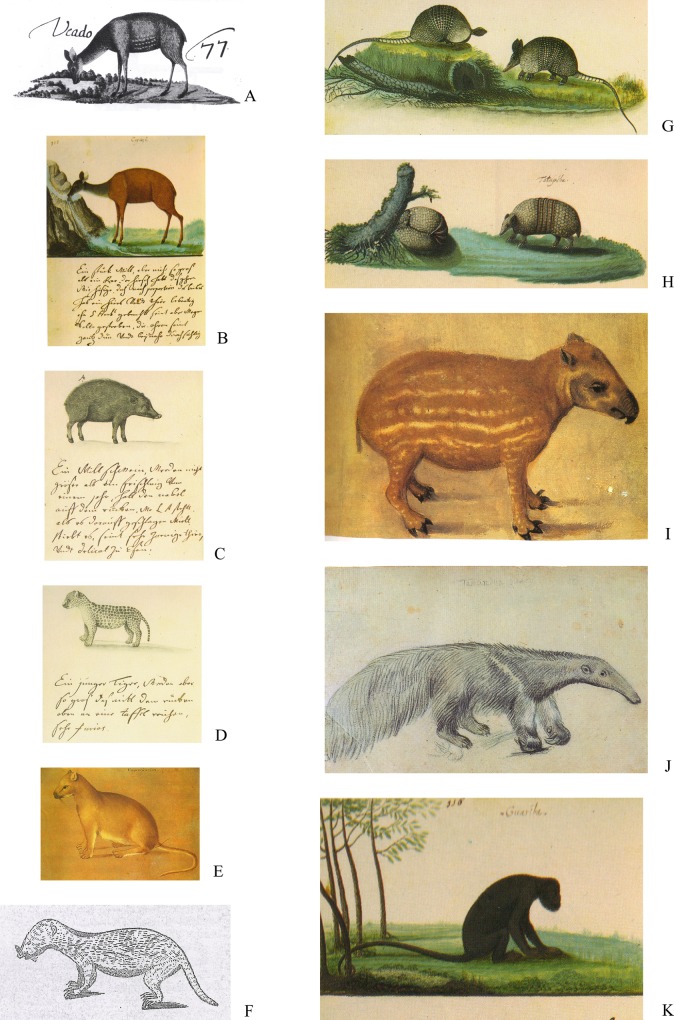
Extinct large mammal species depicted by the first colonizers of the Atlantic coast of northeastern Brazil.A and B) c.f. Mazama americana; C) Tayassu pecari; D) Panthera onca; E) Puma concolor; F) Lutra longicaudis; G) Possibly Cabassous unicinctus (Emmons and Feer, 1997: 10–13 movable bands; tail narrow and long; ears large, funnel-like), but about which Marcgrave says: “This is armoured animals and are able to pull the head and paws, doubling themselves into a ball". Since the only armadillos capable of rolling into a ball are those of the genus Tolypeutes (Eisenberg and Redford, 1999), we assume that Marcgrave was not sure about the distinction between T. tricinctus and other armadillo species; H) Tolypeutes tricinctus; I) Tapirus terrestris; J) Myrmechophaga tridactyla; K) Alouatta belzebul.